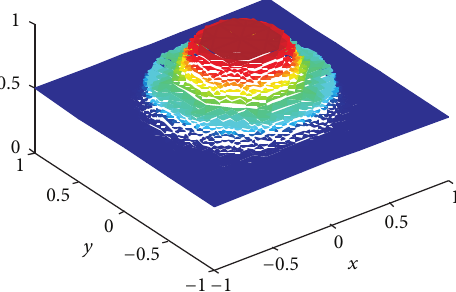
Figure 3: The water surface of the planar dam-break problem at 𝑡 = 0.2 using the adaptive method. The base plane is the 𝑥𝑦 -plane.